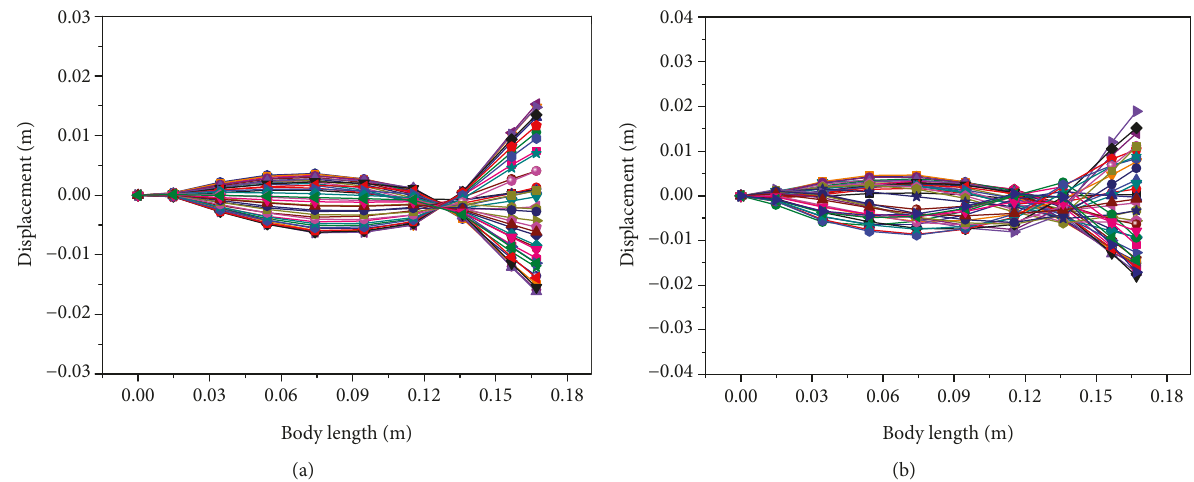
Figure 12: Propulsion modes of the soft robotic fi sh in one cycle at 3Hz in straight-ahead motion. (a) Results in sine waveform. (b) Results in square waveform.